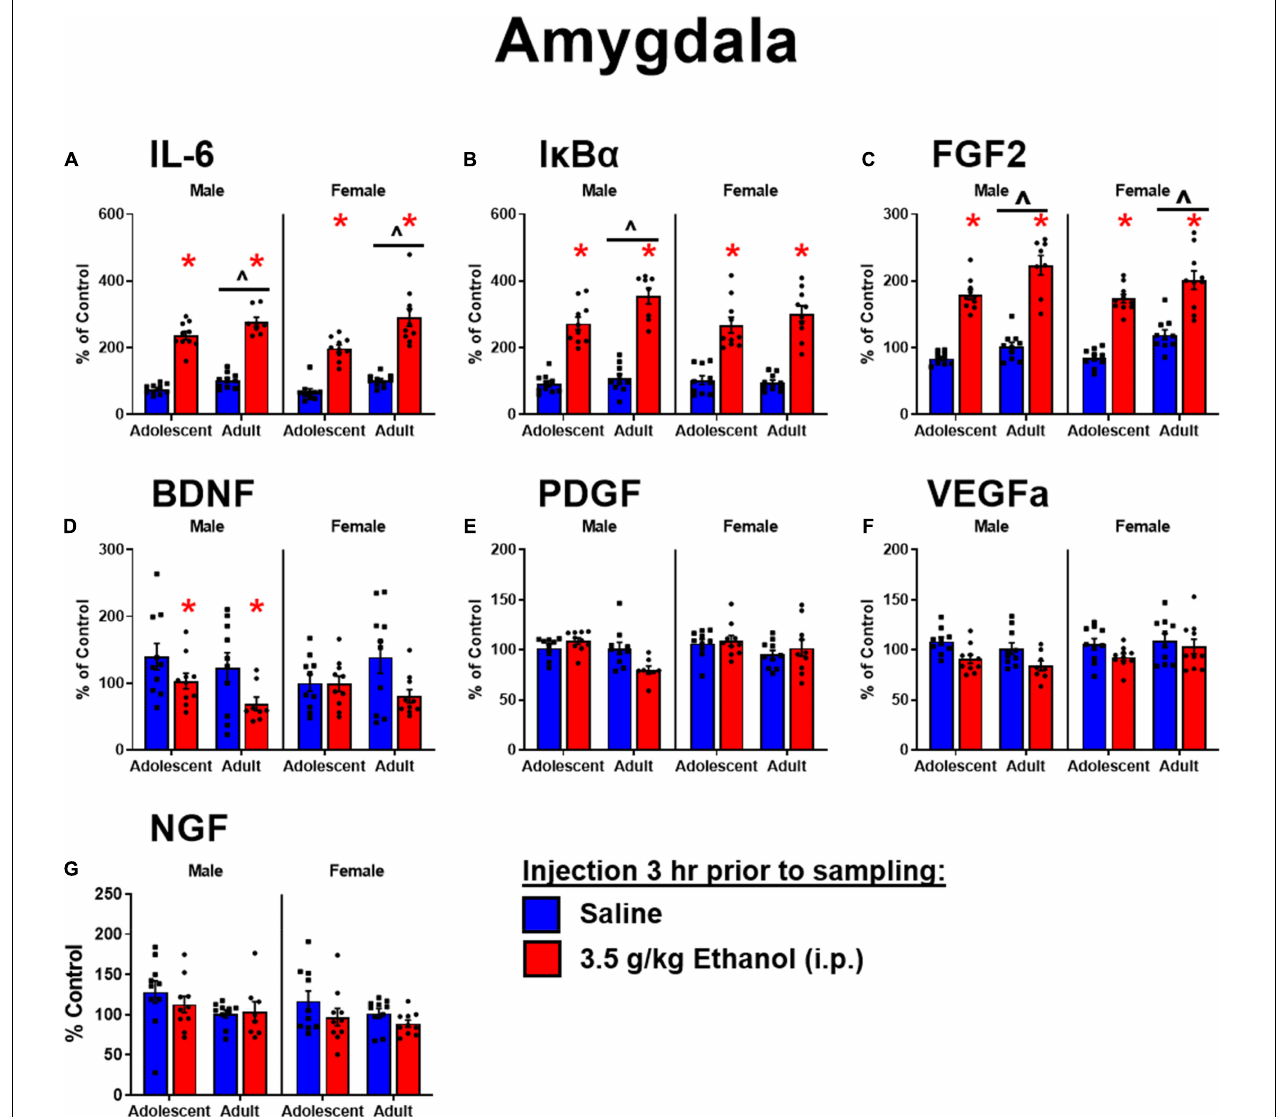
FIGURE 3 | Ethanol-induced gene expression in adolescents and adults. Gene expression of IL-6 (A) , I κ B α (B) , FGF2 (C) , BDNF (D) , PDGF (E) , VEGF α (F) , and NGF (G) in the amygdala were assessed in rats i.p. injection of saline or 3.5 g/kg ethanol. Gene expression data were calculated as a relative change in gene expression using the 2- (cid:49)(cid:49) C(t) method, with (GAPDH) used as a reference gene and the vehicle – saline group serving as the ultimate control for each sex individually. Bars denote group means ± standard error of the mean (represented by vertical error bars). Asterisks (*) signify significant ethanol-induced changes ( p < 0.05), chevron ( ∧ ) indicates main effect of